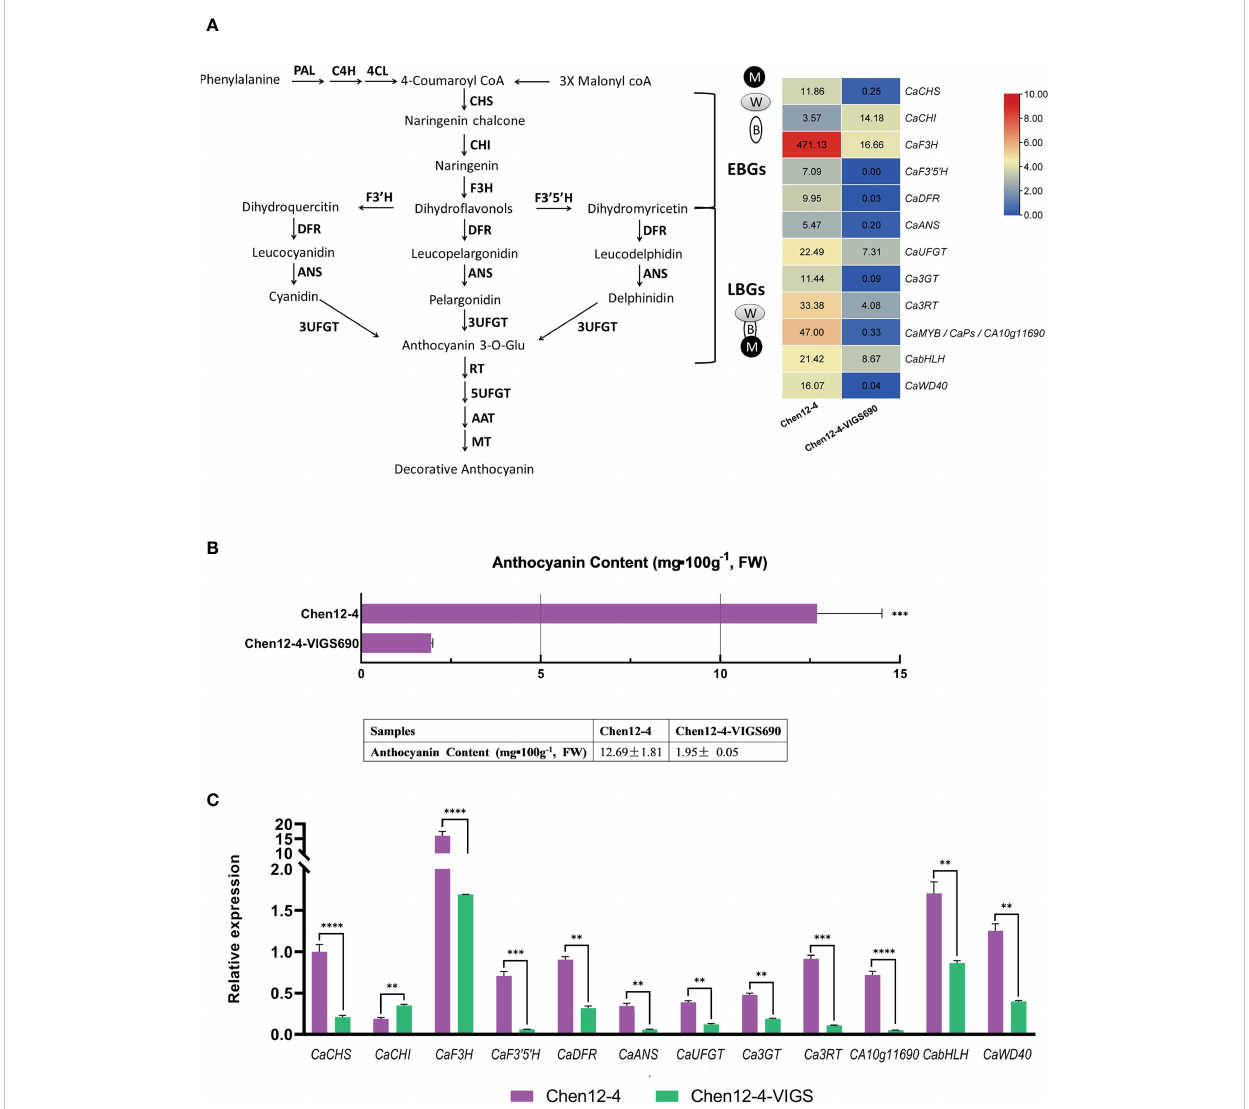
FIGURE 7 Gene expression patterns of the candidate gene CA10g11690 in Chen12-4 and Chen12-4-VIGS lines. (A) Heatmap of the expression of genes related to the anthocyanin biosynthetic pathway via transcriptome analysis. (B) Anthocyanin content of Chen12-4 and its CA1011690- silenced plants. (C) The levels of expression of anthocyanin biosynthetic genes using qPCR analysis. The values of fragments per kilobase of exon per million fragments mapped (FPKM) were used to construct the heat map. The signi fi cant differences were identi fi ed using T-test, asterisks indicate a signi fi cant difference. ****P<0.0001, ***P<0.001,